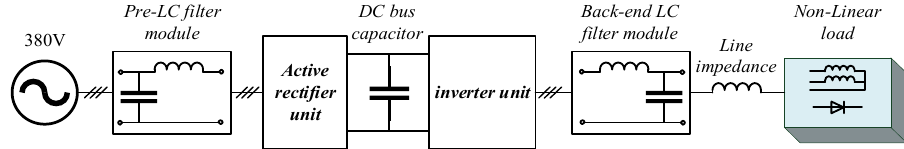
steady state Figure 8. The harmonic change under the voltage feedback control strategy.